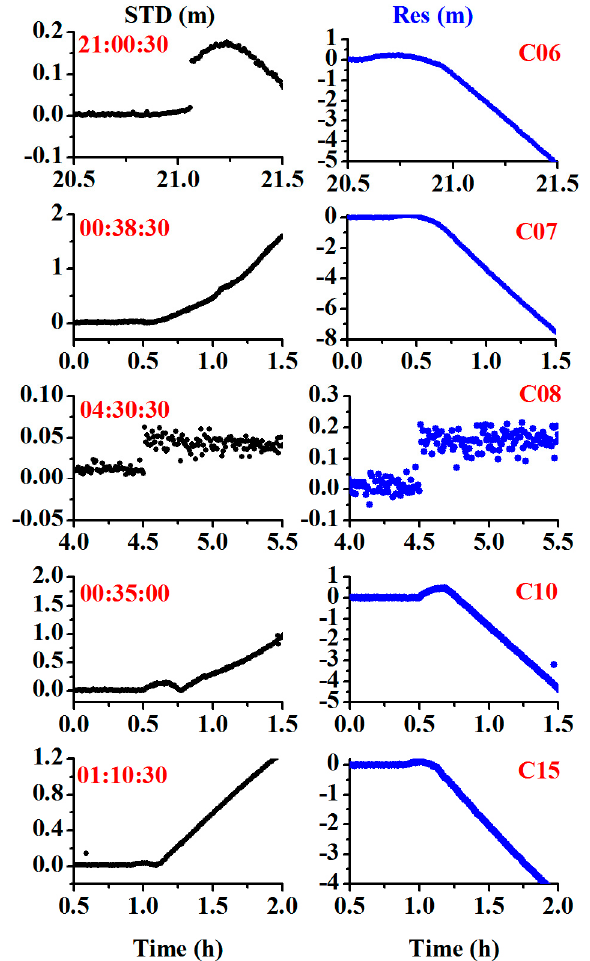
Figure 15. Time series of the STD for the observation residual and array L for the inclined geosynchronous orbit (IGSO) satellites showing orbital maneuver (the left side represents the time discriminant factor, and the right side represents the satellite identification factor).